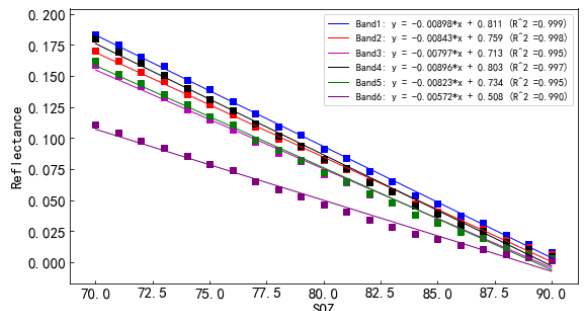
Figure 2. Linear relationship between reflectance of sea fog and solar zenith angle at dawn and dusk in the Yellow Sea and Bohai